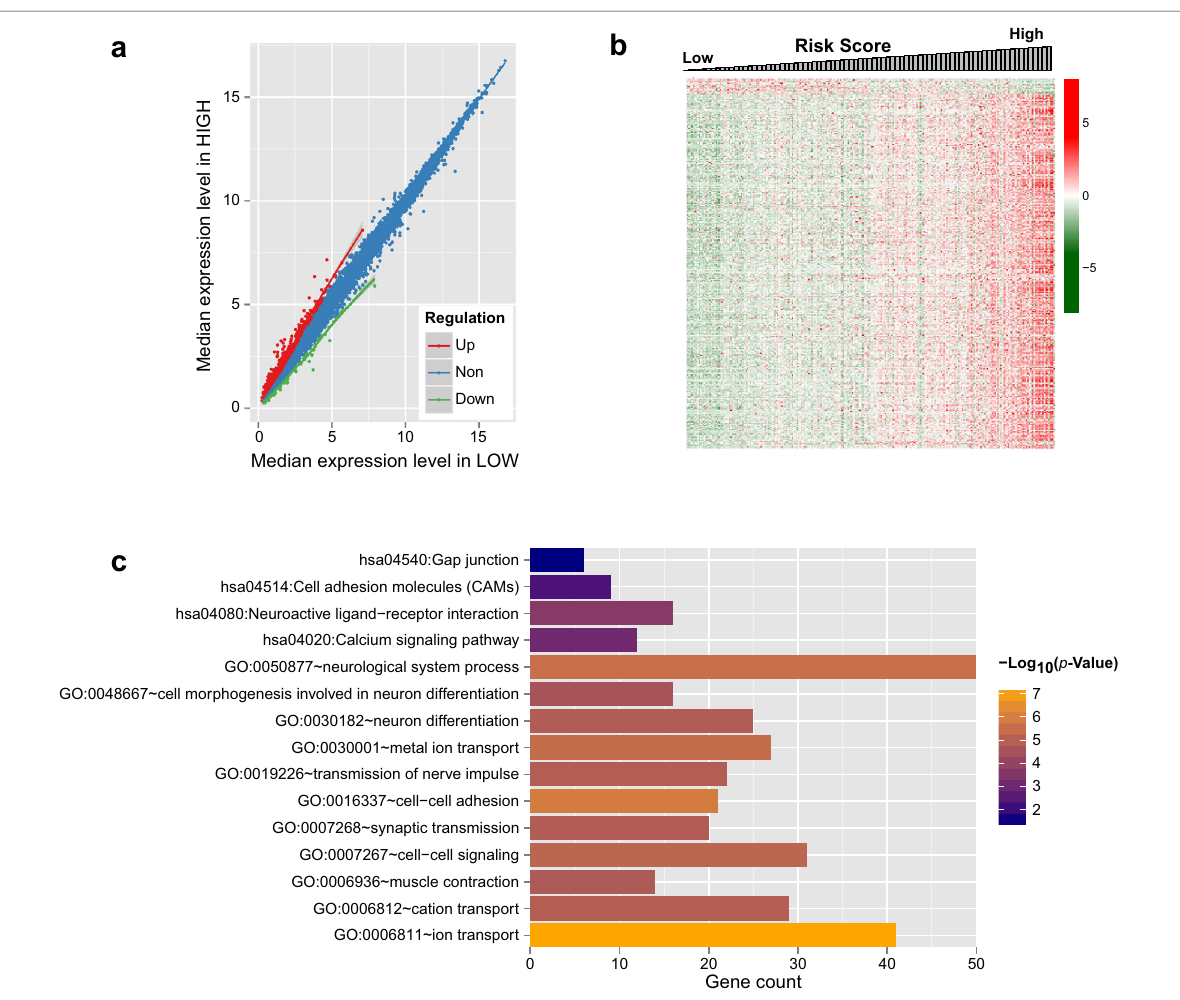
Fig. 5 a Scatter plot of 389 DEGs between high risk and low risk groups. Red, green and blue dots indicate genes are up-regulated, down-regulated, and non-significant differentially expressed mRNAs, respectively. b Heat map of 389 DEGs between high risk and low risk groups. From left to right represents the changing process of MiRScore value from low to high. c GO and KEGG enrichment analyses of DEGs. Horizontal axis and vertical axis represent gene number and term, respectively; the color of the bar indicates the significant p value, and the closer the color is to orange, the higher the